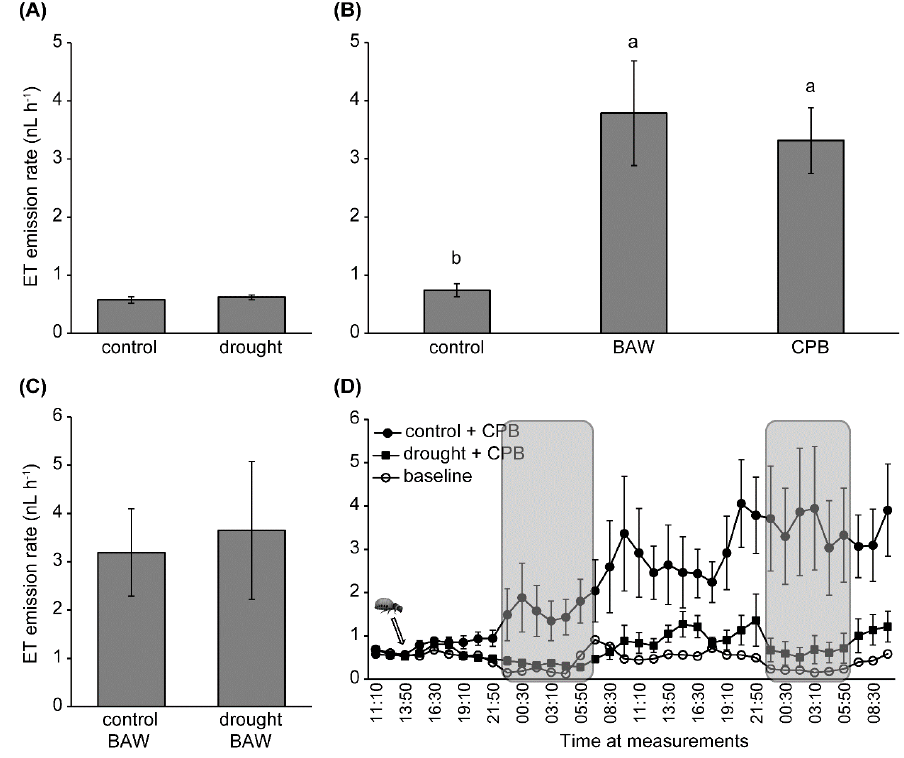
Figure 3. Effects of water availability and insect herbivory treatments on ethylene (ET) emission (nL h − 1 ) from S. dulcamara leaves. ( A ) Plants were well ‐ watered (control) or under drought treatment for five days before the ET measurements. Each replicate ( n = seven per treatment) is the average of two consecutive measurements (20 minutes per measurement). ( B ) Leaves that were undamaged (control, n = six) or fed on by Spodoptera exigua (BAW, n = nine) and Leptinotarsa decemlineata (CPB, n = six) larvae for a 24 ‐ h period. Each replicate represents the average emission rate over the whole 24 ‐ h period. Error bars are standard errors. Different letters (a, b, c) indicate significant differences between herbivory treatments (LSD p < 0.05). ( C ) Plants were under five ‐ day control ( n = four) or drought ( n = six) treatments before a 24 ‐ h herbivory treatment by BAW. Each replicate depicts the average emission rate over the whole period. ( D ) Plants were under five ‐ day control (filled dots) or drought treatments (filled squares, n = six per treatment) before a 48 ‐ h herbivory treatment by CPB. The arrow indicates when herbivory treatment started by adding a larva to each cuvette. One extra plant under control treatment without herbivory was included as the baseline of the ET emission rate (empty dots). Shaded blocks indicate dark periods.